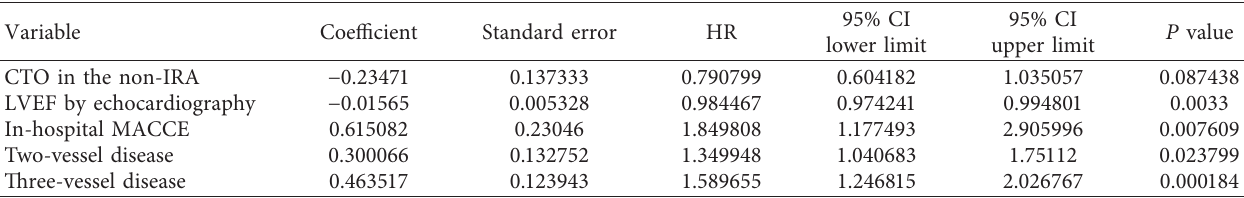
Figure 1: Kaplan–Meier survival curve of all patients with acute myocardial infarction divided by concurrent chronic total occlusion in the non-infarct-related artery. Plot of survival functions in patients with chronic total occlusion versus patients without chronic total occlusion. Table 4: Multivariable regression model of all-cause MACCE during the entire follow-up period in the whole study population (only showing CTO in the non-IRA and other variables with statistical significance).